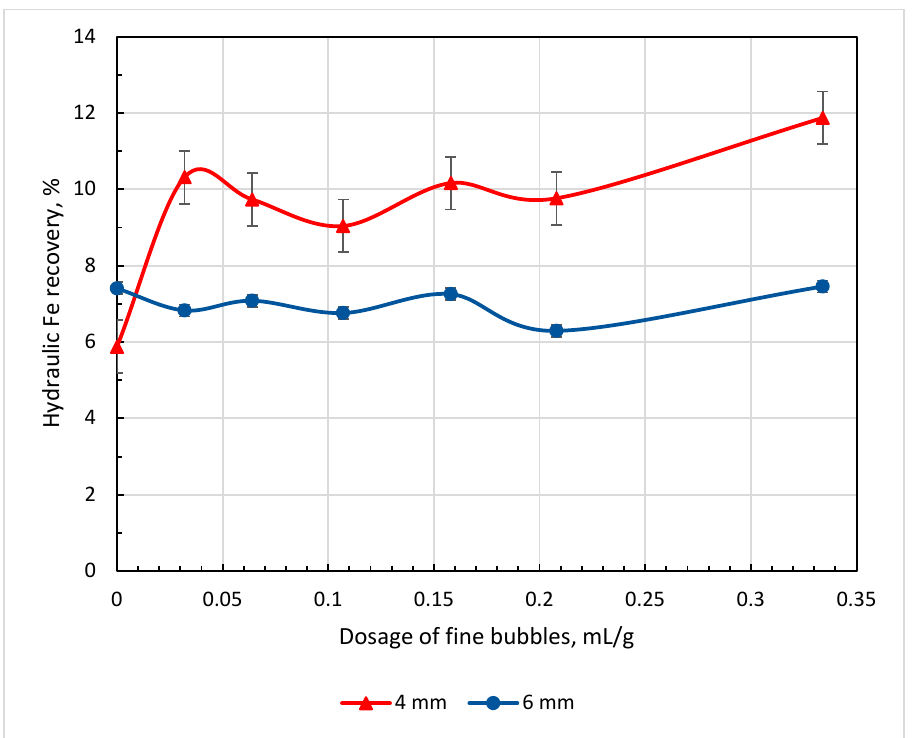
Figure 14. Dependence of the share of the flotation recovery of iron in tailings (froth product) on the fine bubble dosage after treatment in TFRs having 4 and 6 mm inner diameters. CTAB dosage—20 g/t, fine bubble dosage—0.21 mL/g.